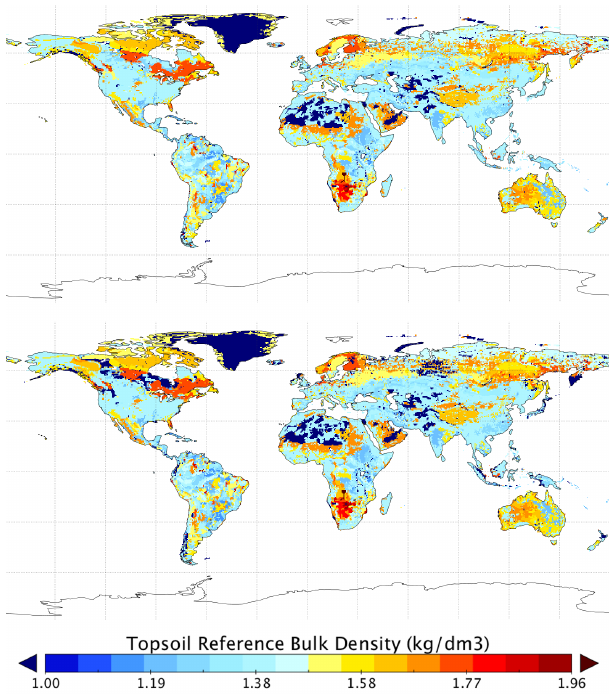
Figure 7. HWSD topsoil reference bulk density before (top) and after (bottom) correction at 0.5 ◦ resolution.